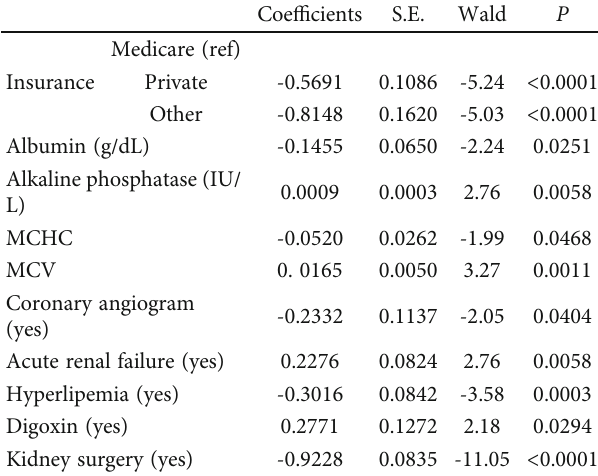
Table 3: Cox regression